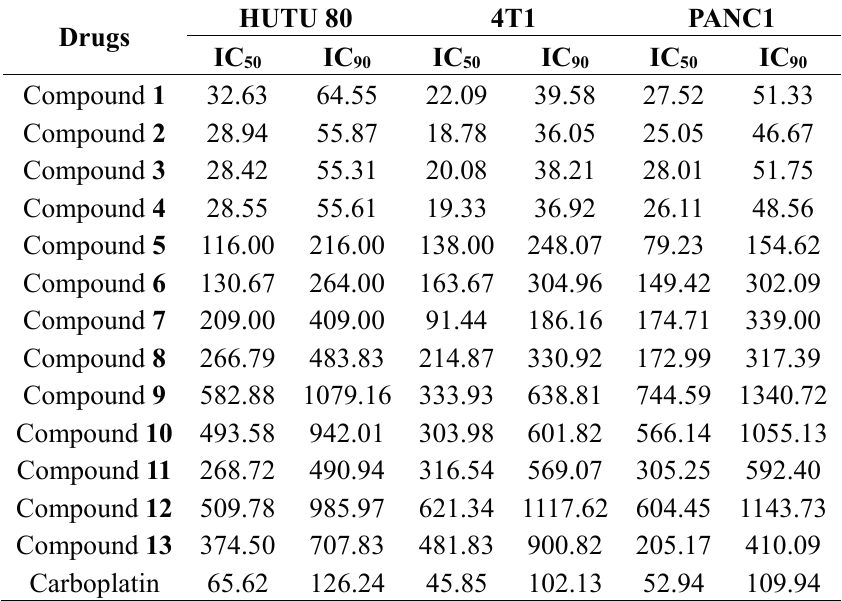
Table 3. IC 50 and IC 90 values of compounds 1 – 13 and carboplatin against three tumor cell lines ( μ